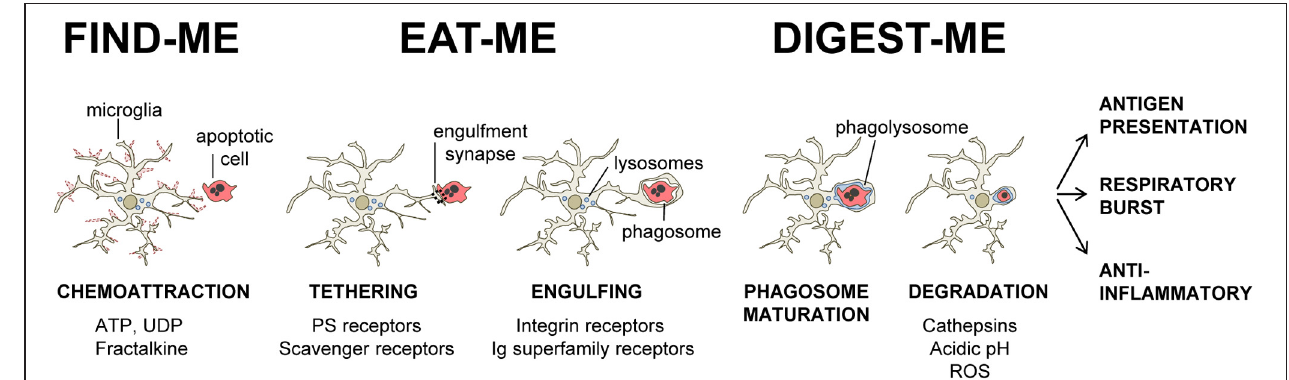
FIGURE 1 | Three-step model of microglial phagocytosis. In physiological conditions, microglial processes are highly motile and respond to chemoattractant molecules released by damaged or apoptotic cells (“find-me” signals) such as fractalkine and extracellular nucleotides (ATP, UDP). Next, an engulfment synapse is formed between a series of microglial